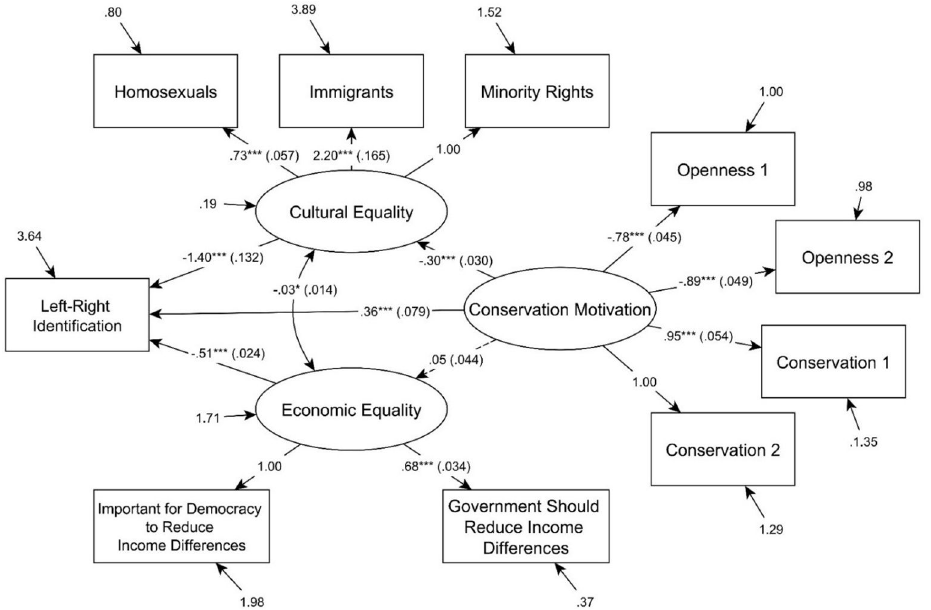
Figure 2. Pathway Model Explaining Left-Right Ideological Preferences – Western Europe. Note. Unstandardized regression weights are followed by standard errors in parentheses. Unstandardized residual variances are displayed for every variable. ( χ 2 = 523.54; df = 30; CFI = .920; RMSEA = .045). * p < .05. ** p < .01. *** p < .001.